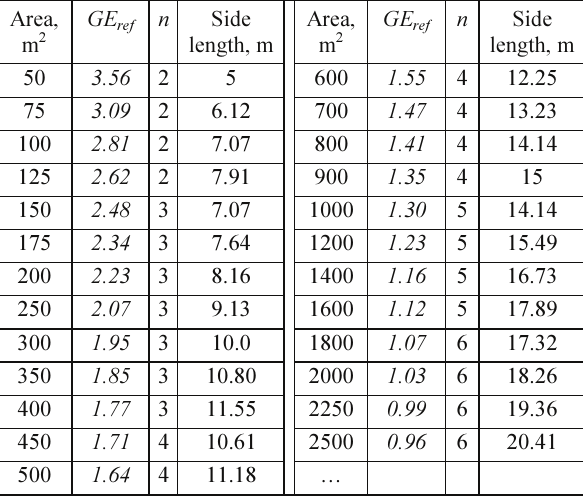
Table 7. Geometric characteristics of reference buildings (storey height h = 3.2 m)